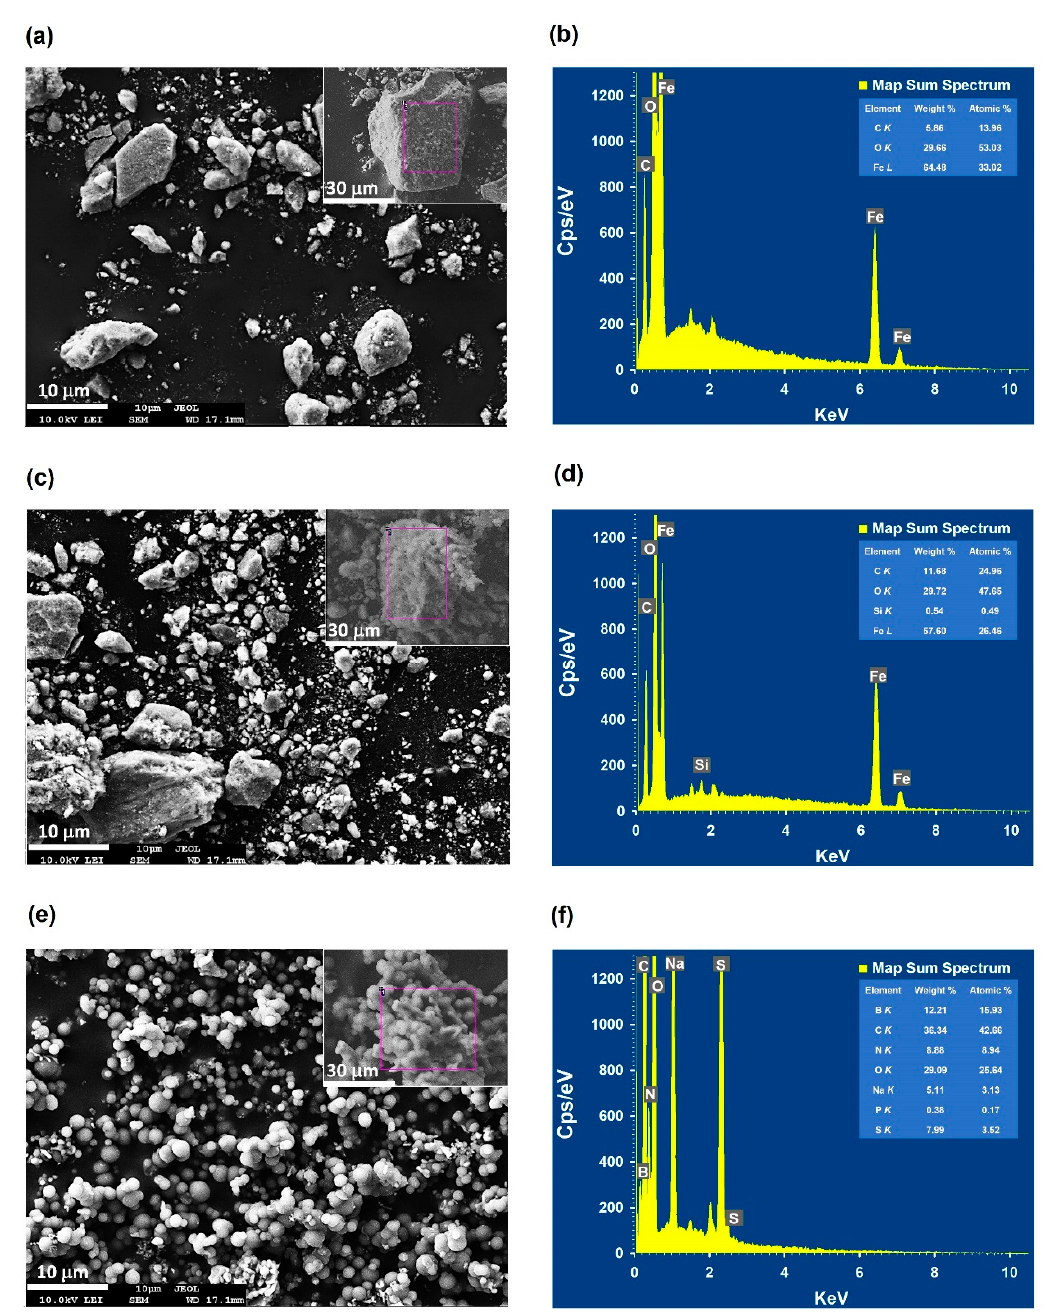
Figure 4. FESEM images and EDS spectra of bare ( a , b ) and APTES-coated ( c , d ) MNPs, and N450D-mCLEAs ( e , f ).